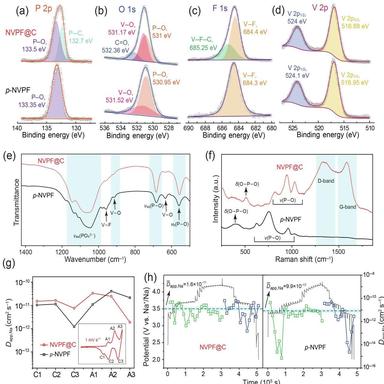
(Color online) The comparisons of XPS, IR, Raman and Dapp,Na between NVPF@C and p-NVPF. (a–d) high-resolution XPS spectra and the corresponding deconvolution results for the orbital peaks of P 2p, O 1s, F 1s, and V 2p; (e) FTIR, and (f) Raman spectra; Dapp,Na values calculated from (g) the CV tests at various scan rates and (h) GITT technology. Inset in (g): one representative CV pattern collected at scan rate of 1 mV s1 .